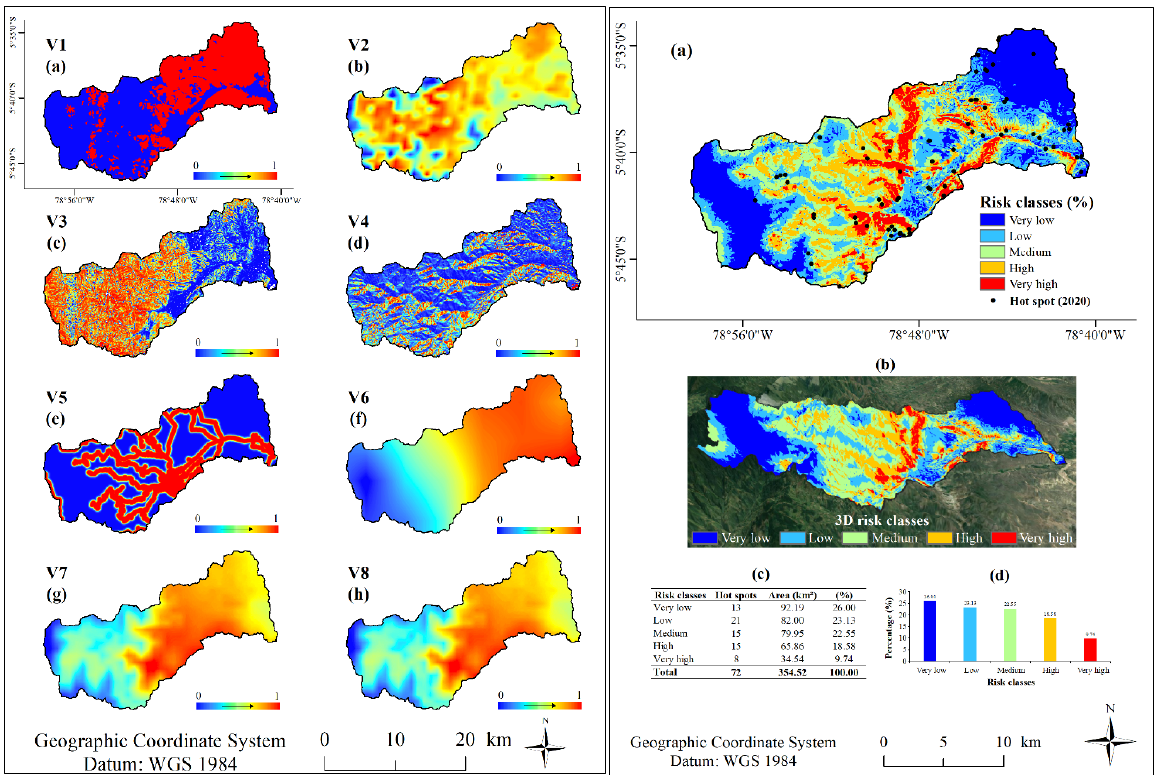
Fig. 6. Fuzzified images of variables used Fig. 7. Forest fires risk for Amojú river basin